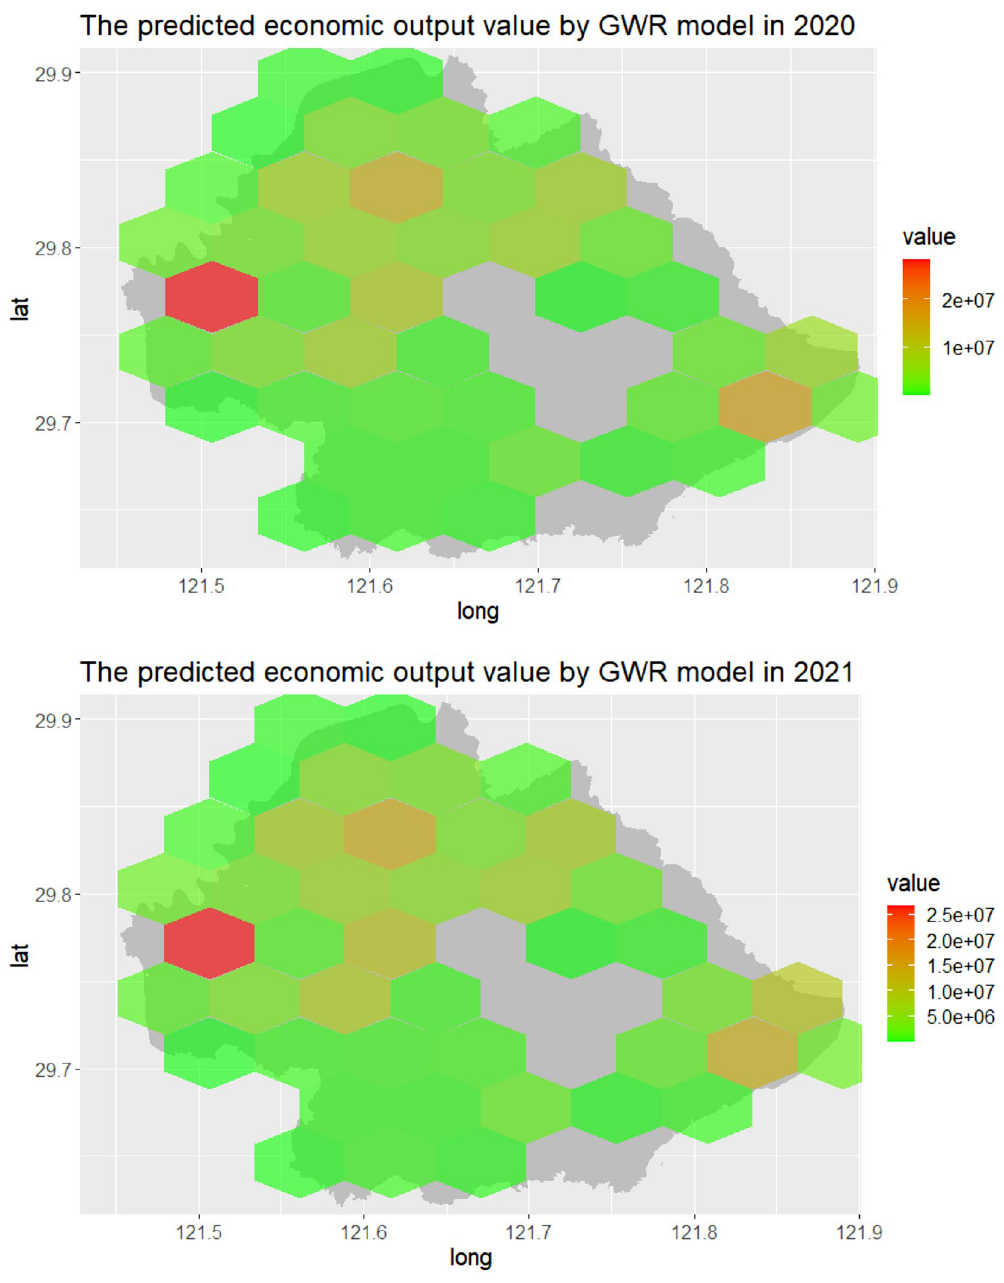
Figure 5. The spatial distribution of the predicted annual economic output value based on the number of yearly positive online news by GWR model in Yinzhou,